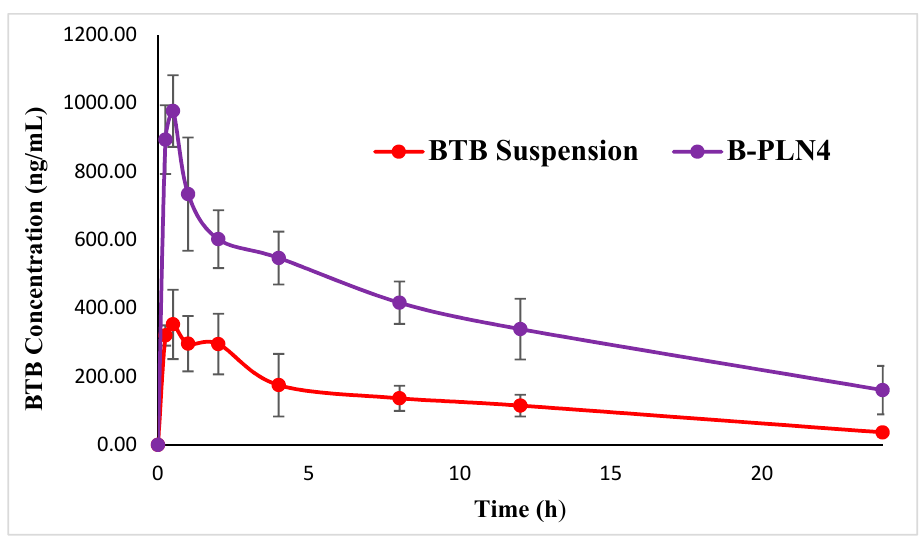
Figure 6. Comparative plasma concentration versus time profile of BTB after oral administration of BTB pure suspension and BPLN4 (1 mg/kg) in rats ( n = 6).